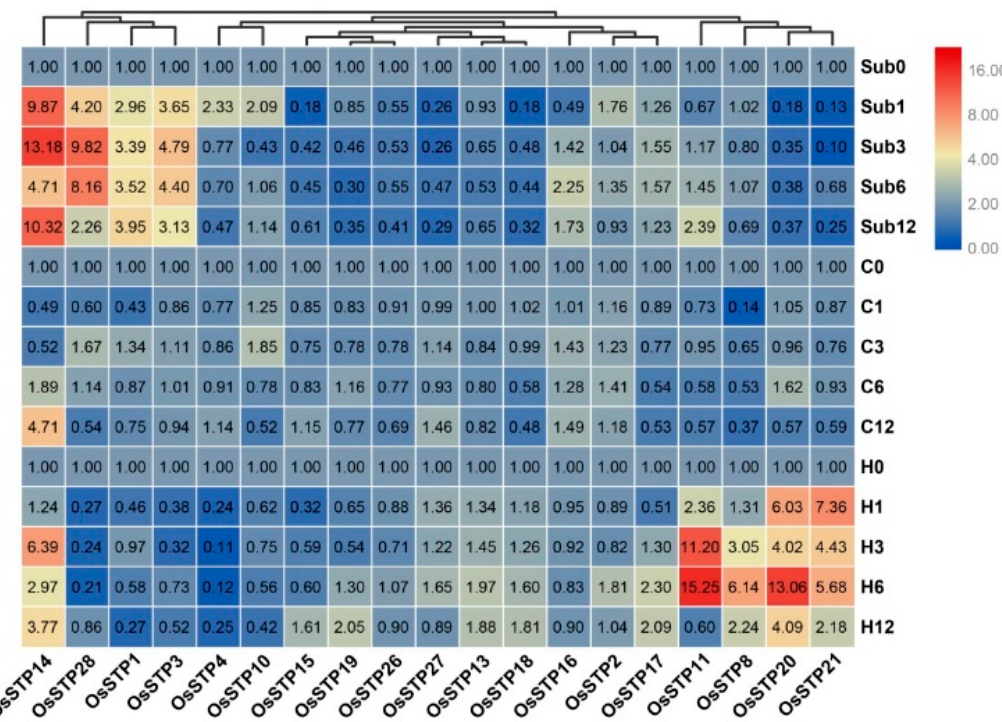
Figure 5. Expression changes of the rice seedling under cold stress, high-temperature stress, and submergence stress by qRT-PCR. Sub0, Sub1, Sub3, Sub6, and Sub12 represent 0 hours, 1 hours, 3 hours, 6 hours, and 12 hours after the submergence stress. C0, C1, C3, C6, and C12 mean 0 hours, 1 hour, 3 hours, 6 hours, and 12 hours after cold stress (4 °C). H0, H3, H6, and H12 represent 0 hours, 1 hour, 3 hours, 6 hours, and 12 hours after high-temperature stress (40 °C). The color scale represents fold changes (2 −ΔΔ CT method): the red color indicates high up-regulation and the green color represents low up-regulation.